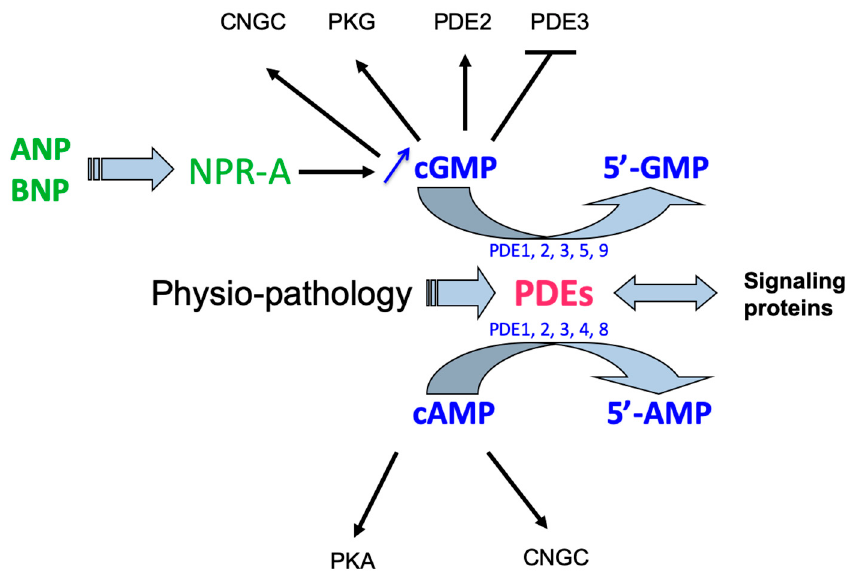
Figure 1. Interactions between natriuretic peptides and cyclic nucleotide pathways. By stimulating the NPR-A receptor, the natriuretic peptides ANP and BNP increase cGMP formation from guanosine triphosphate (GTP). This increase in cGMP, in addition to cGMP-protein kinase activation (PKG), might also activate PDE2 (which hydrolyses both cAMP and cGMP), inhibits PDE3 (which hydrolyses mainly cAMP, but also cGMP with a higher affinity), whereas it increases